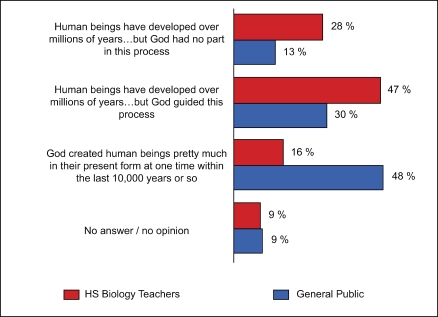
High School Biology Teachers' Personal Beliefs Concerning Human Origins, Compared with a Representative Sample of the General Public, Spring 2007Notably, we find that teachers' personal beliefs are linked to classroom instruction. The teachers who chose the “young earth” creationist position devoted 35% fewer class hours to evolution (9.6 hours) than all other teachers (14.7 hours).